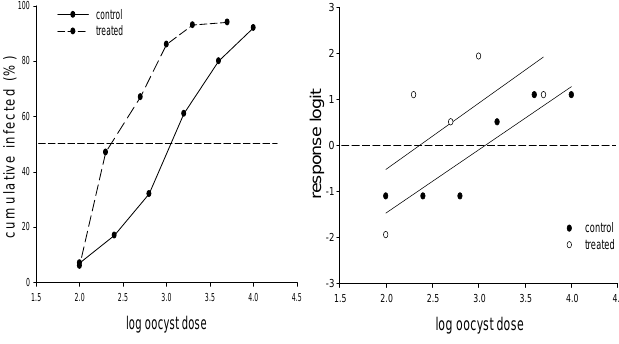
Figure 3: Inactivation of C. parvum oocysts with lime. Dose-response curves were obtained using the cumulative method 37 (left) and the logit method 38 (right). The 50% cumulative infection and 0 logit used for determining the ID values are shown with dashed horizontal lines. Note 50 the increase in oocyst infectivity (lower ID to